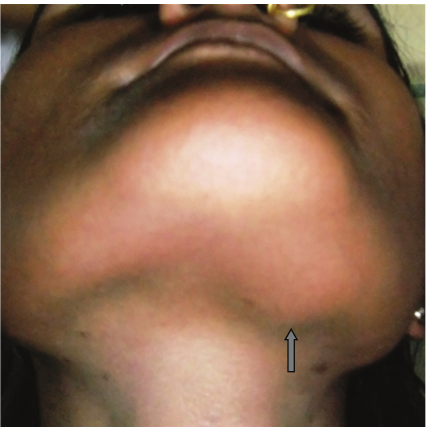
Figure 1: Swelling at the left submandibular region.